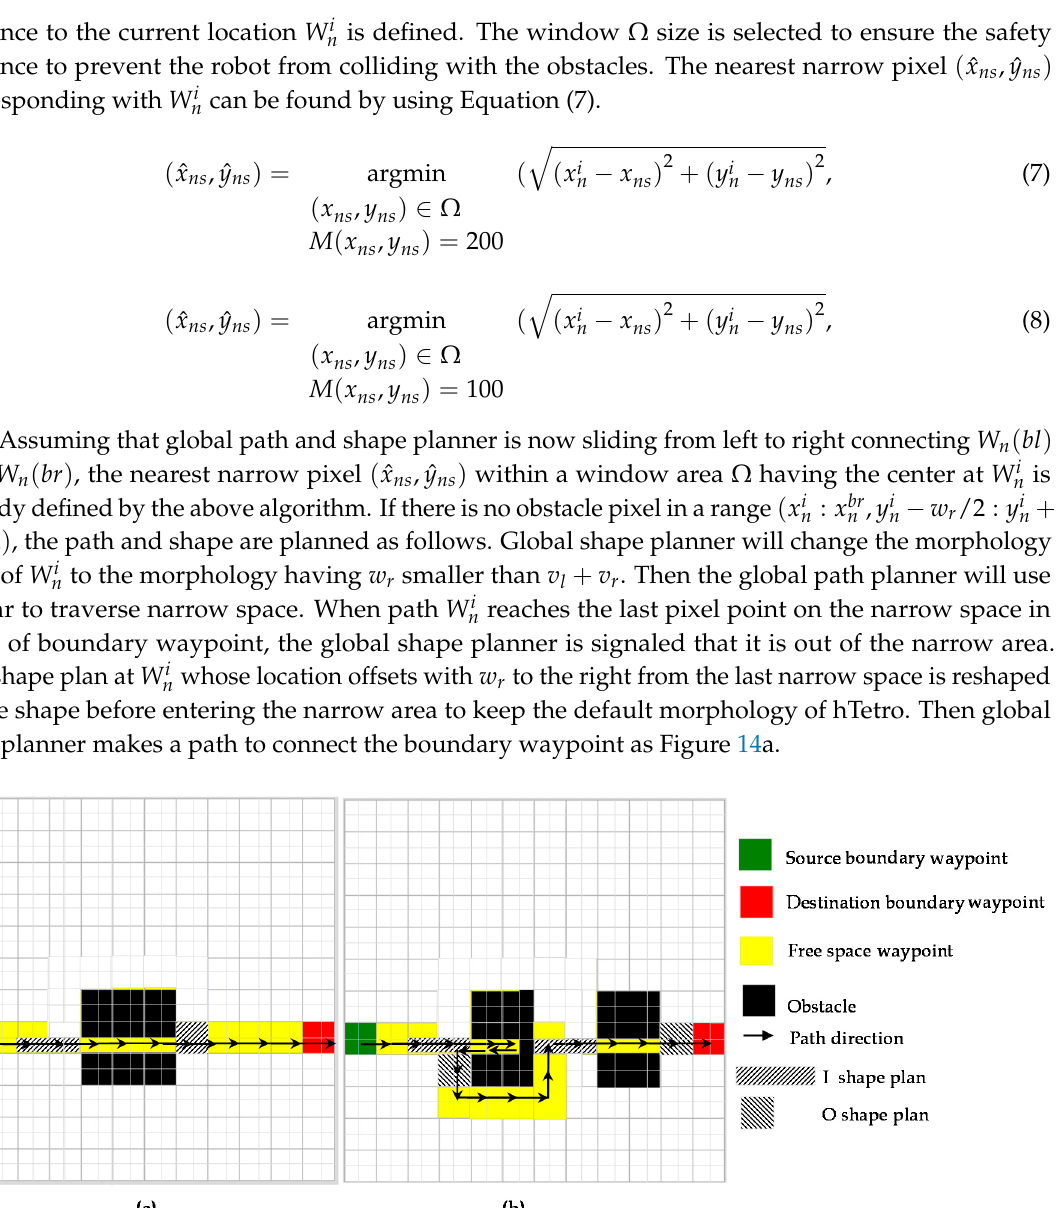
Figure 15. Testbed environment setups. ( a ) Real testbed environment, ( b ) small map with simple obstacles, ( c ) large map with moderate obstacles, ( d ) large maps with complicated obstacles.